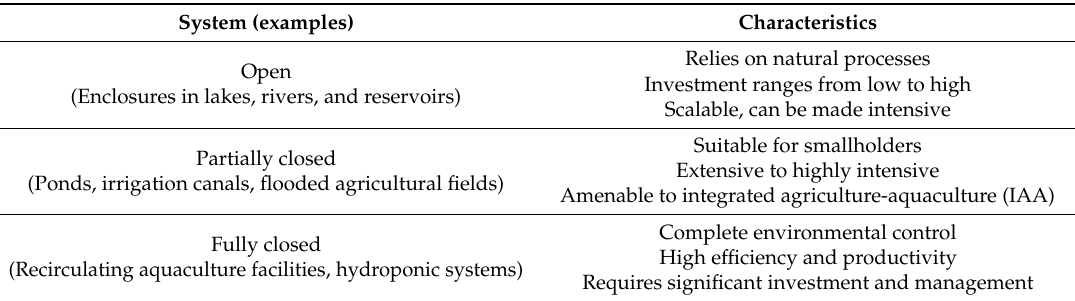
Table 1. Diversity of aquaculture